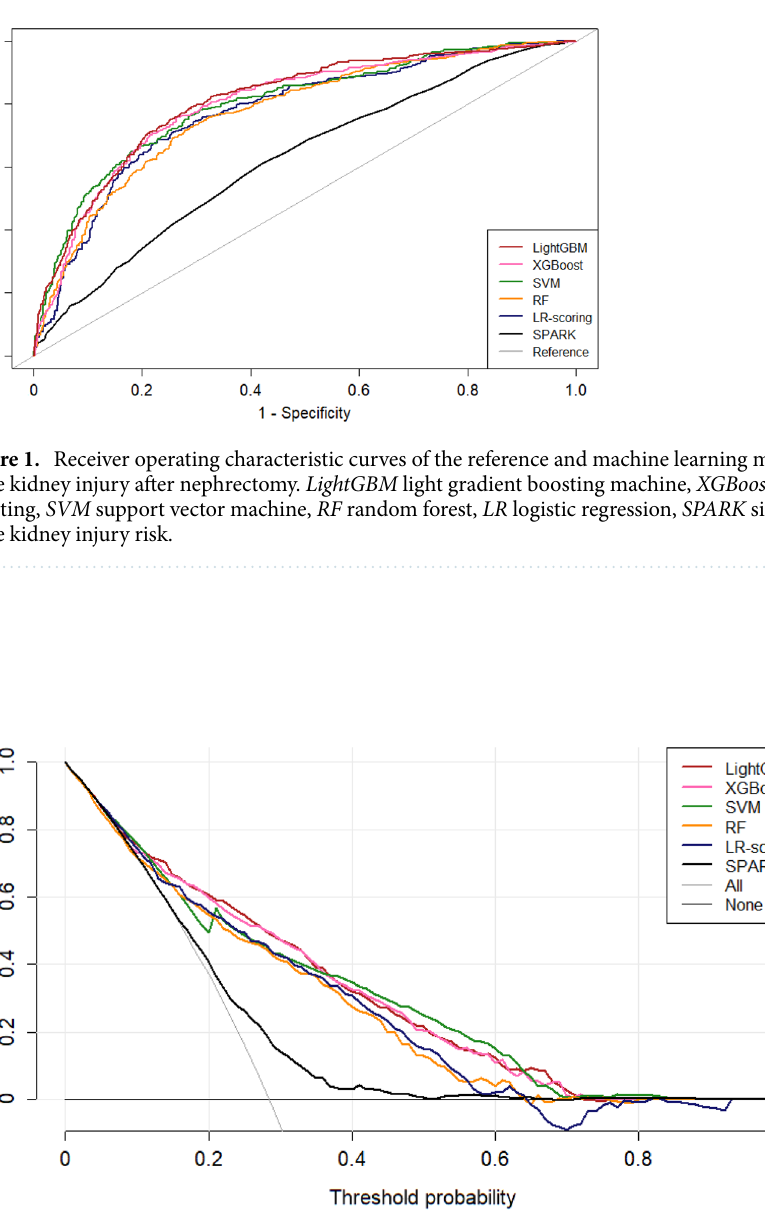
Figure 2. Decision curve analysis. LightGBM light gradient boosting machine, SVM support vector machine, RF random forest, LR logistic regression, SPARK simple postoperative acute kidney injury